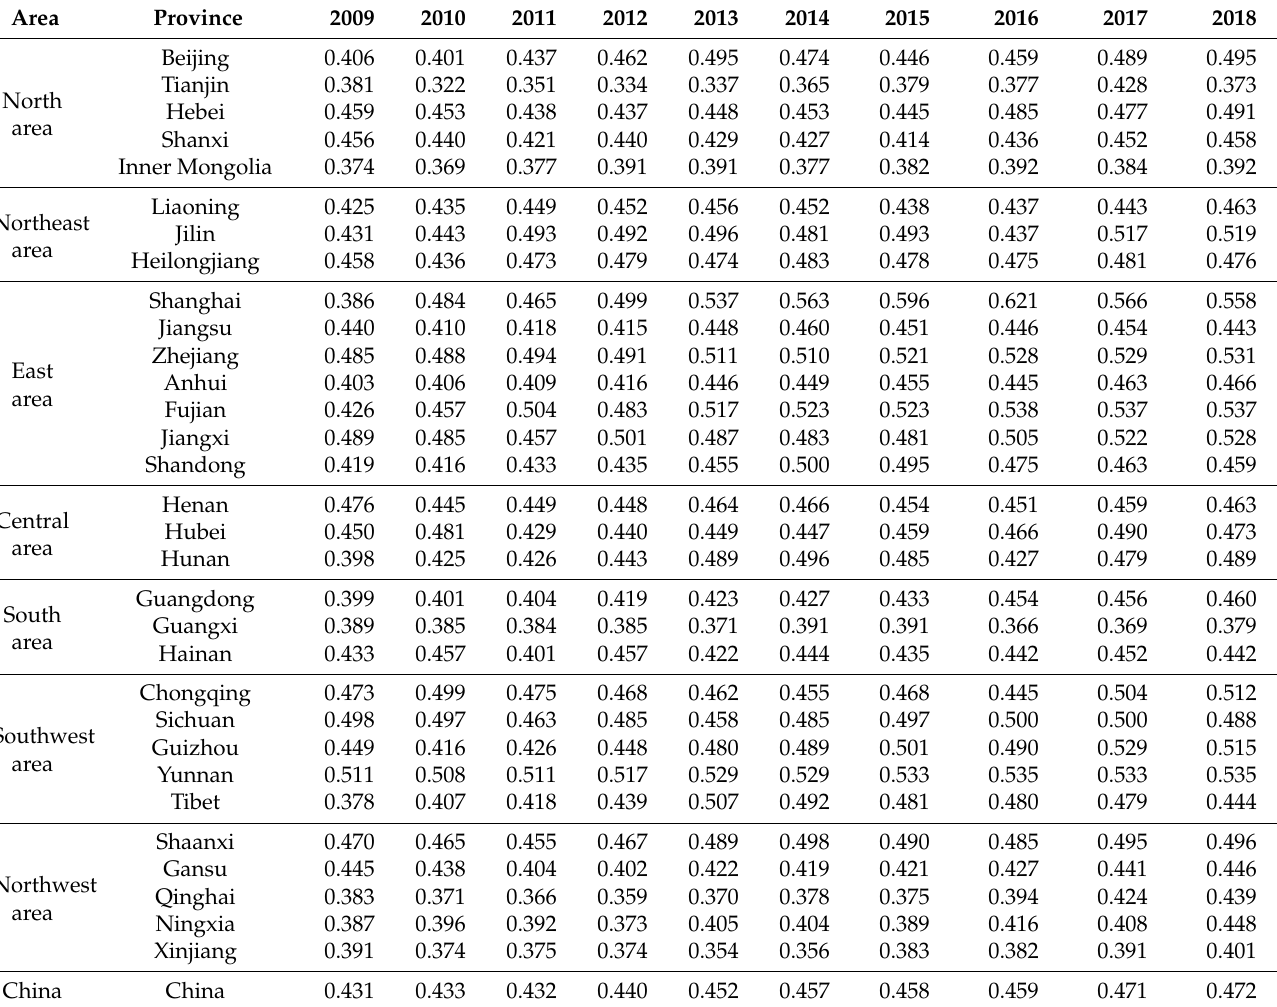
Table 3. The calculated results of FES indices of 31 provinces in China,